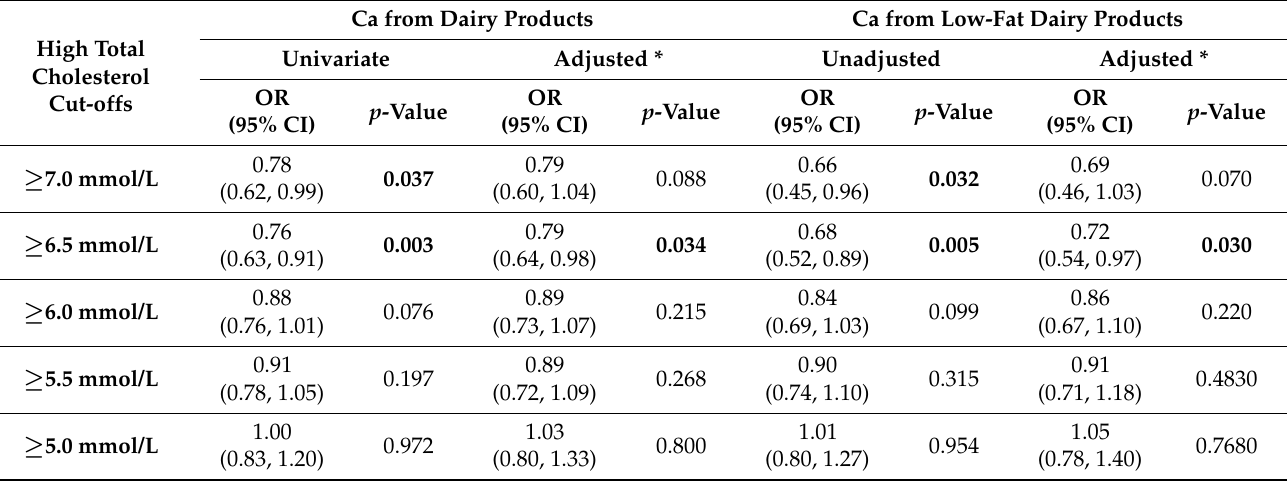
Table 6. Univariate and adjusted ORs and 95 CIs for having high total cholesterol according